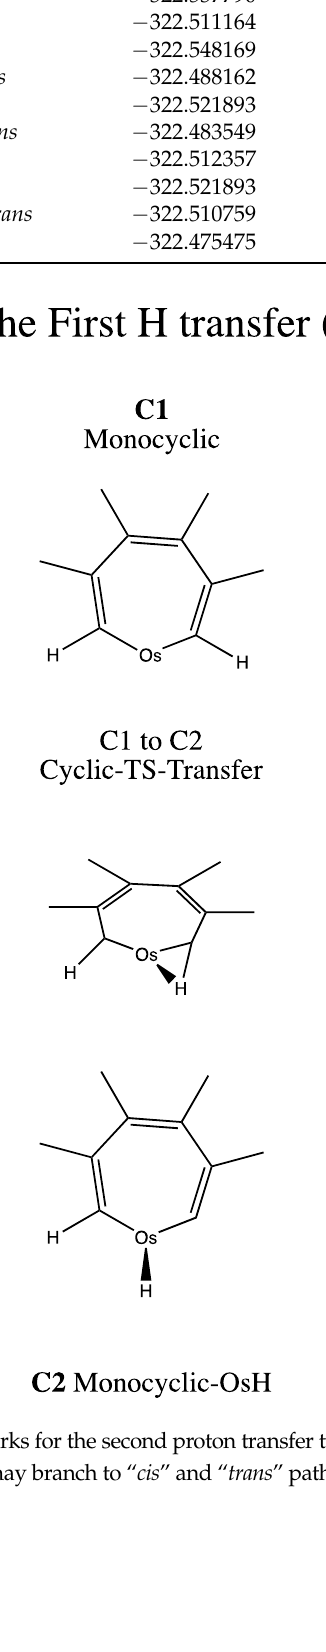
Table 2. Energetics ( ω B97XD/def2-tzvp) for landmarks along the C path for H transfer to polycyclic Os species from the most stable C species of OsC 6 H 6 cation. Species labels and Gibbs energies (G) in Hartrees are reported along with relative Gibbs energies in electron volts (eV). The energy reference point is the energy of the C 6v complex of the Os cation with benzene, OsC 6 H 6 + (see Table 1).